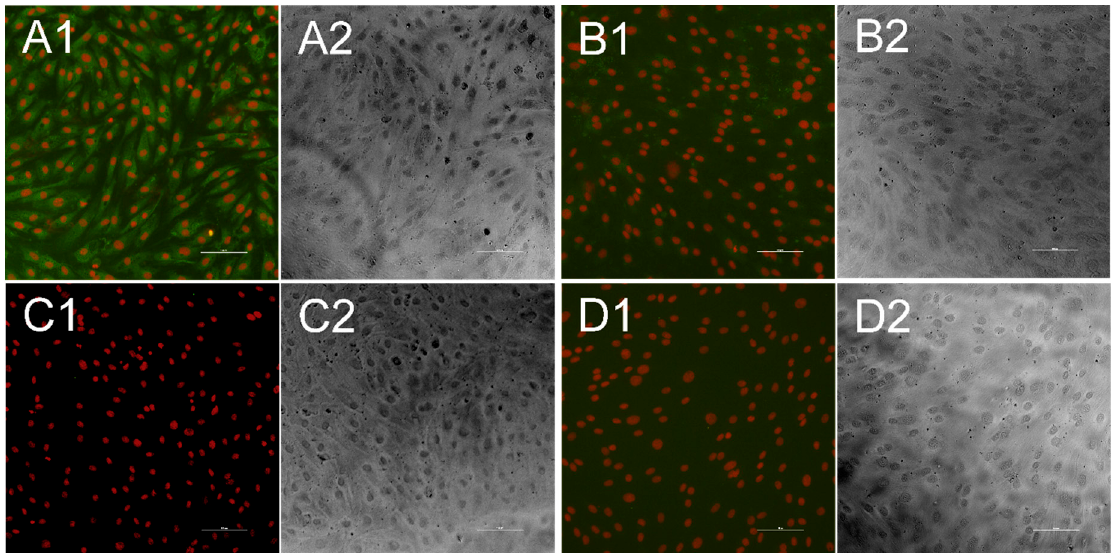
Figure 4. Indirect immunofluorescence test for bovine viral diarrhea virus 1 (BVDV)-specific antibodies. Each fluorescence picture (1) is presented alongside a bright field picture, that was taken at the same position (2). Cell nuclei appear in red, while antibodies against BVDV are stained in green. When antibodies were present in the sample they bound to KOP-R cells infected with the CP7 isolate ( A ), while no green fluorescence could be seen when antibody-positive samples were tested against uninfected cells ( B ). Antibody-negative serum sample neither showed significant interaction with infected cells ( C ) nor with uninfected cells ( D ). Bar is 100 µm.